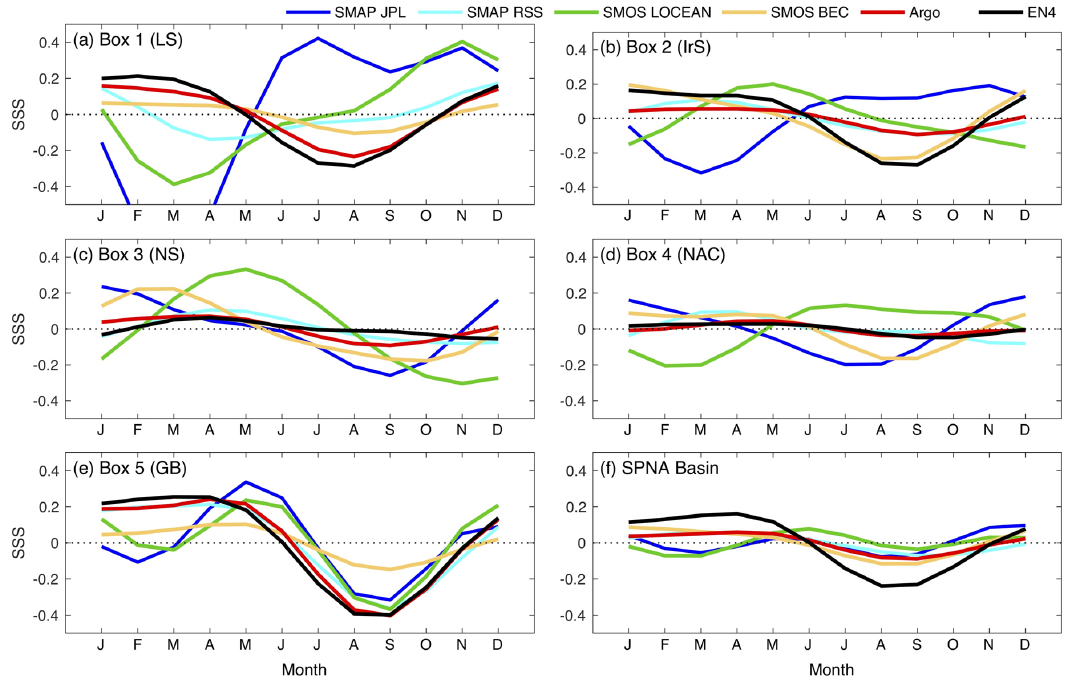
Figure 8. The the estimated semiannual cycles averaged over the five selected boxed areas depicted in Figure 1b and the entire basin. ( a ) Box 1. LS: The Labrador Sea. ( b ) Box 2. IS: The Irminger Sea. ( c ) Box 3. NS: The Nordic Seas. ( d ) Box 4. SPG: The Subpolar Gyre. ( e ) Box 5. NFL: Newfoundland. ( f ) The entire subpolar North Atlantic basin.